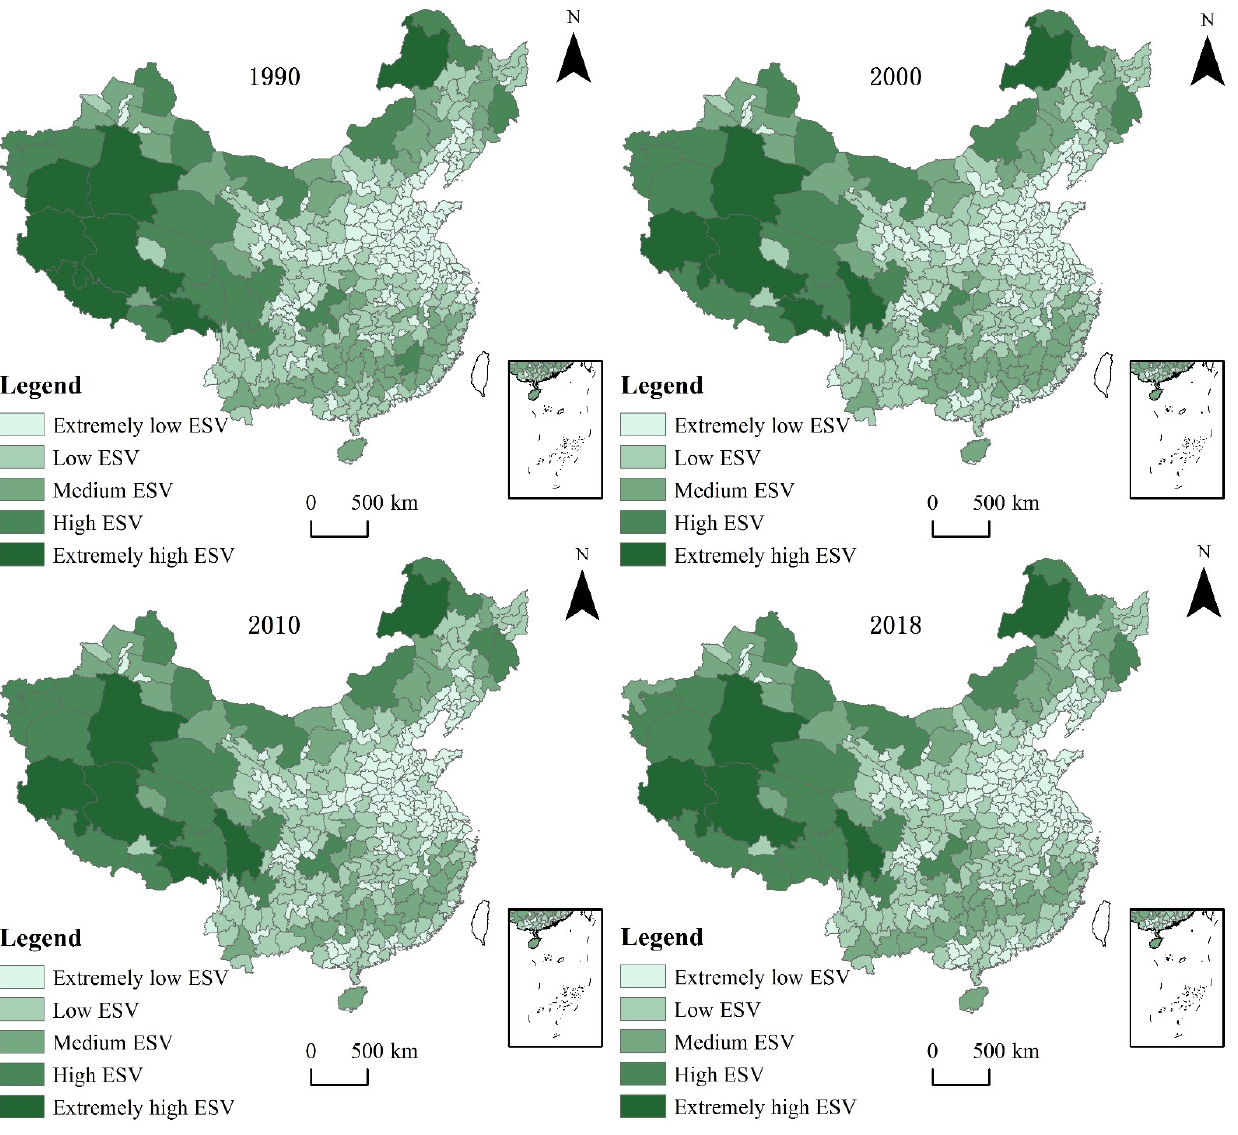
Figure 4. Spatial distribution characteristics of ESV in the study area.